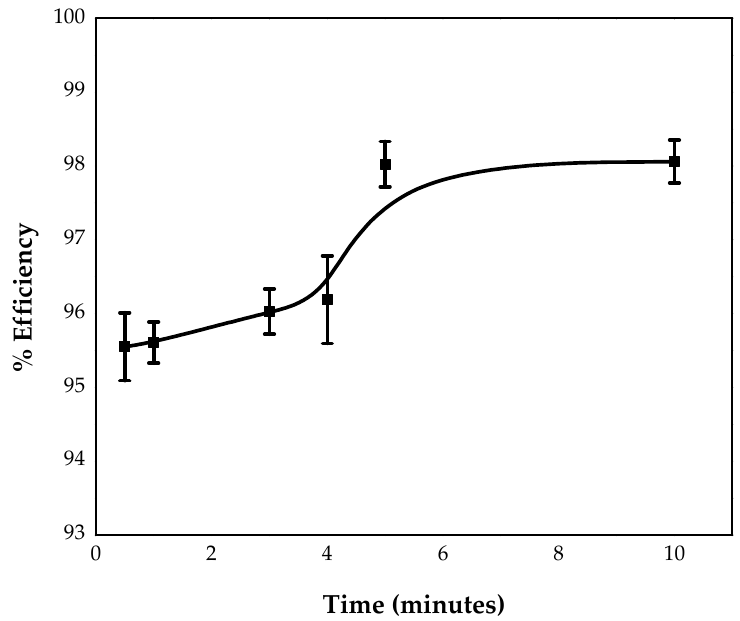
Figure 7. Effect of time on alizarin extraction by DES-3 (initial concentration of alizarin = 1000 mg/L, pH = 6.37, DES dosage = 0.15 mL at 25 °C).